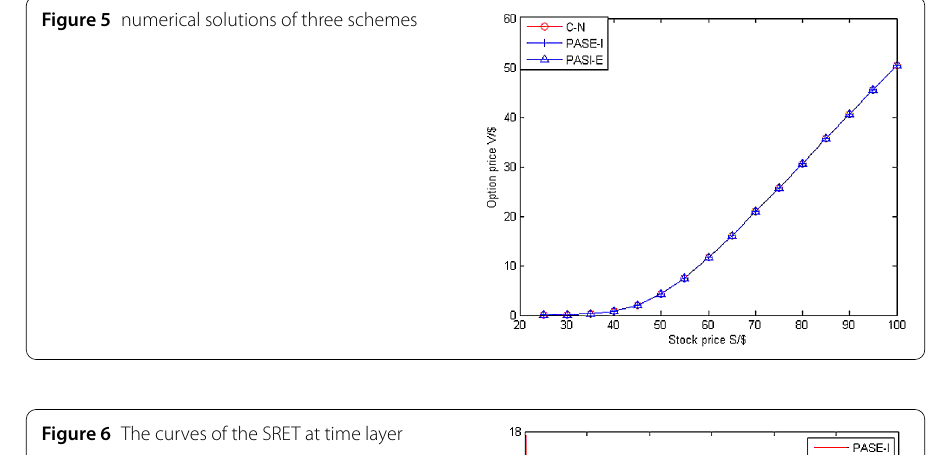
Figure 6 The curves of the SRET at time